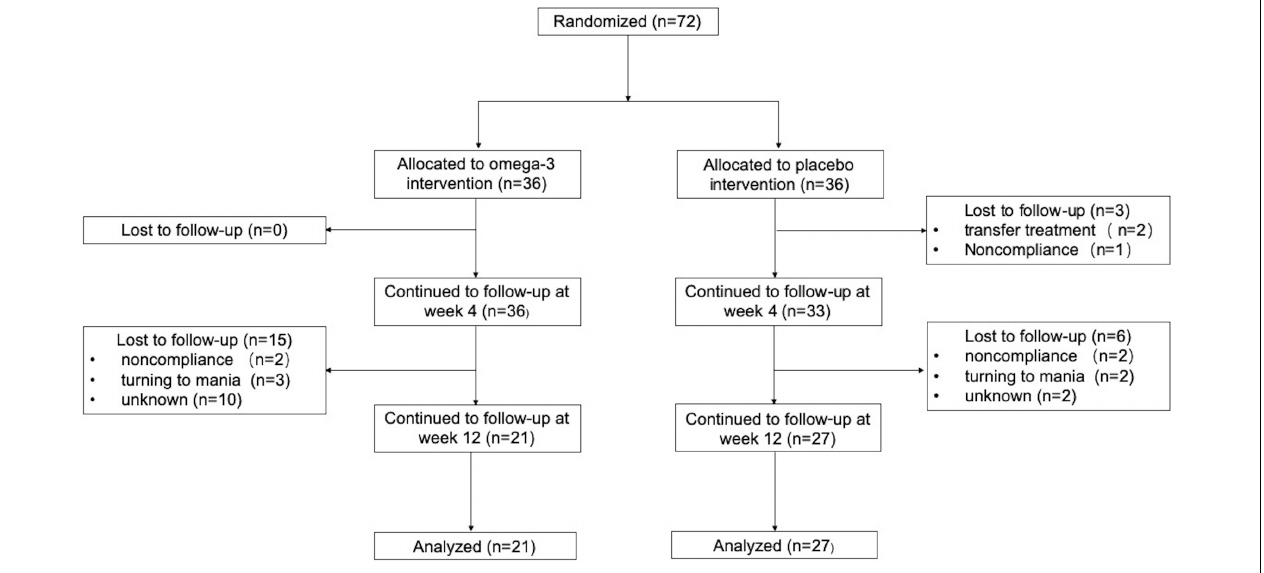
FIGURE 1 | Flow of participants in the Trial. Non-compliance includes being unwilling to take medicine and taking medicine